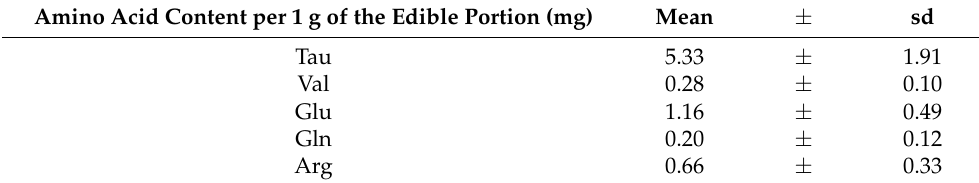
Table 1. Amino acid contents in the bivalve were determined using the proposed LC-HRMS/MS